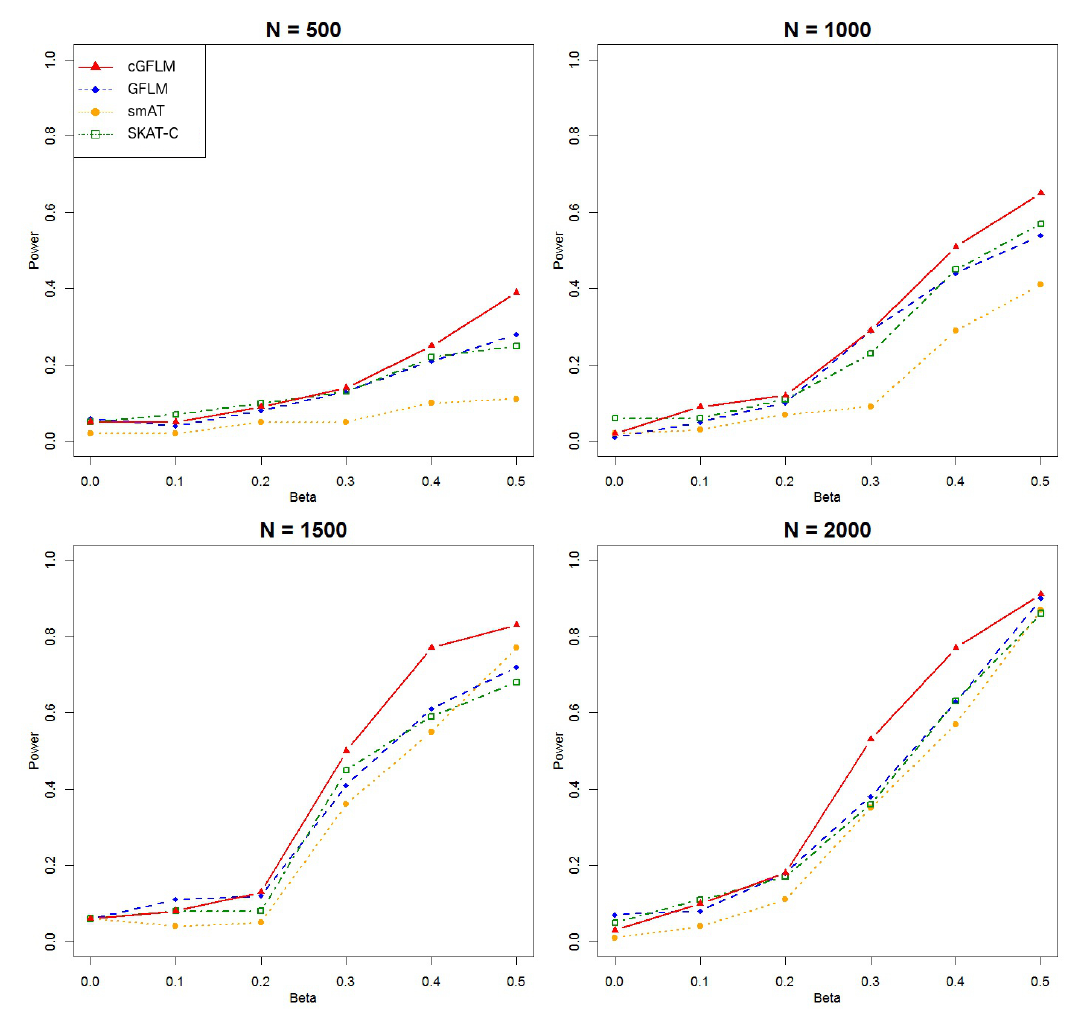
Figure A1. Power simulation for binary outcomes based on the CHRNA7 gene, single causal